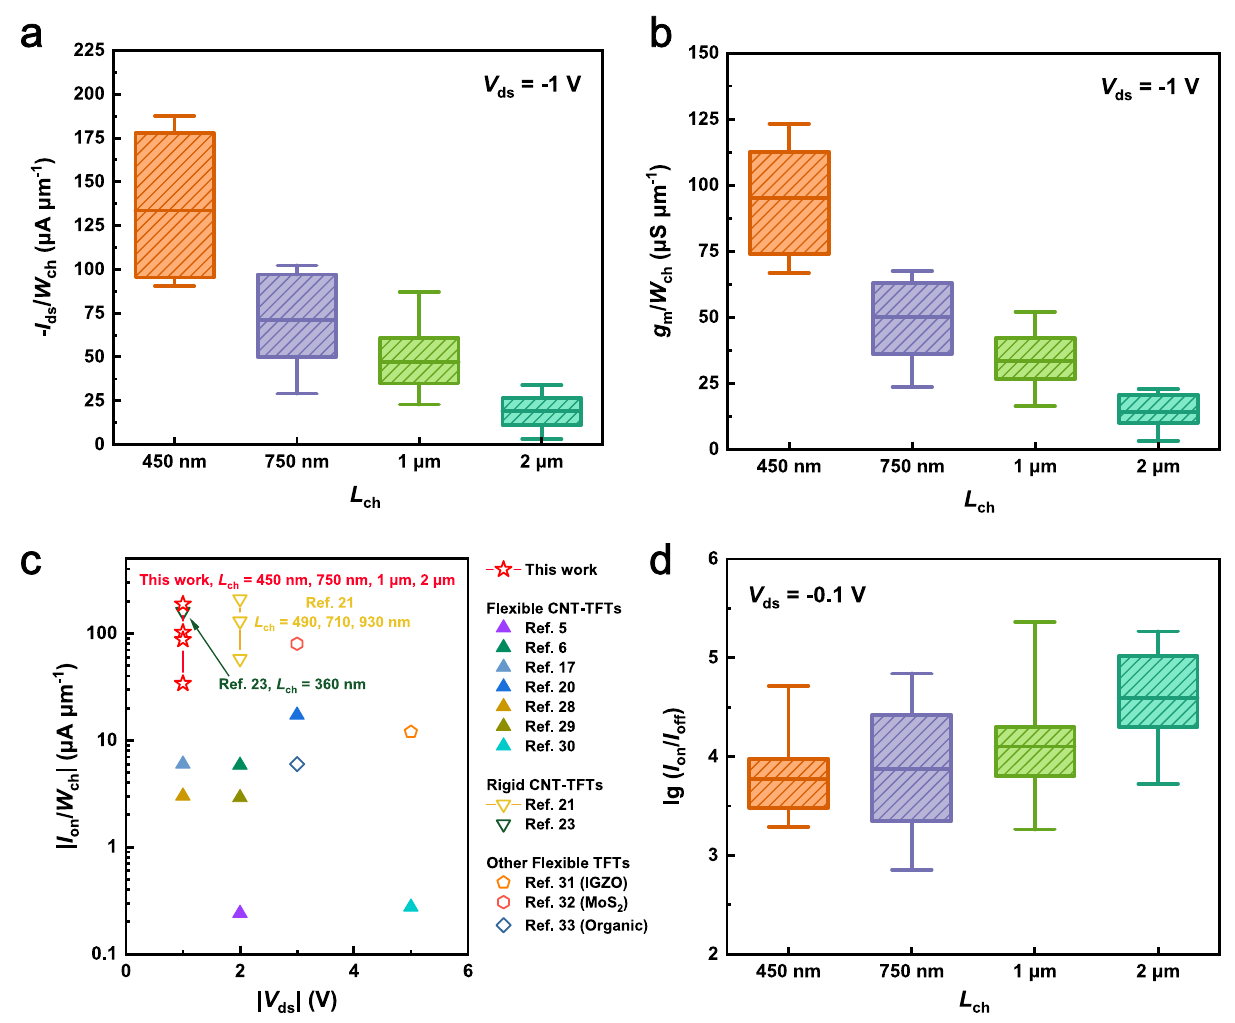
Fig. 3 | Scaling behavior of fl exible CNT-TFTs. Statistical results of width- normalized a on-state current I on / W ch and b transconductance g m / W ch extracted from devices with L ch =450nm, 750nm, 1 μ m, 2 μ m. c I on / W ch comparison of our fl exible CNT-TFTs with other representative fl exible TFTs and CNT-TFTs on rigid